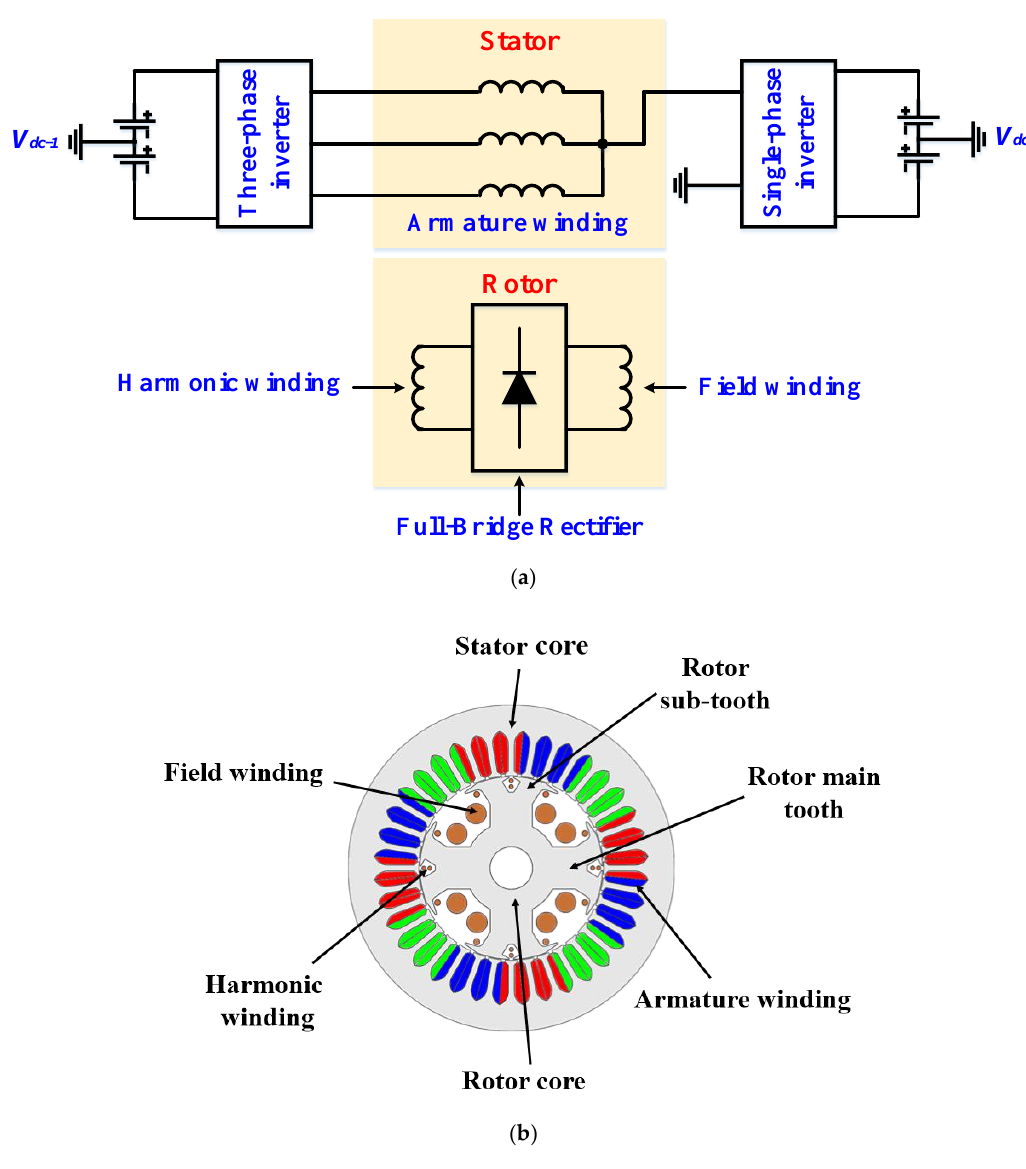
Figure 1. ( a ) Proposed topology and ( b ) machine model.